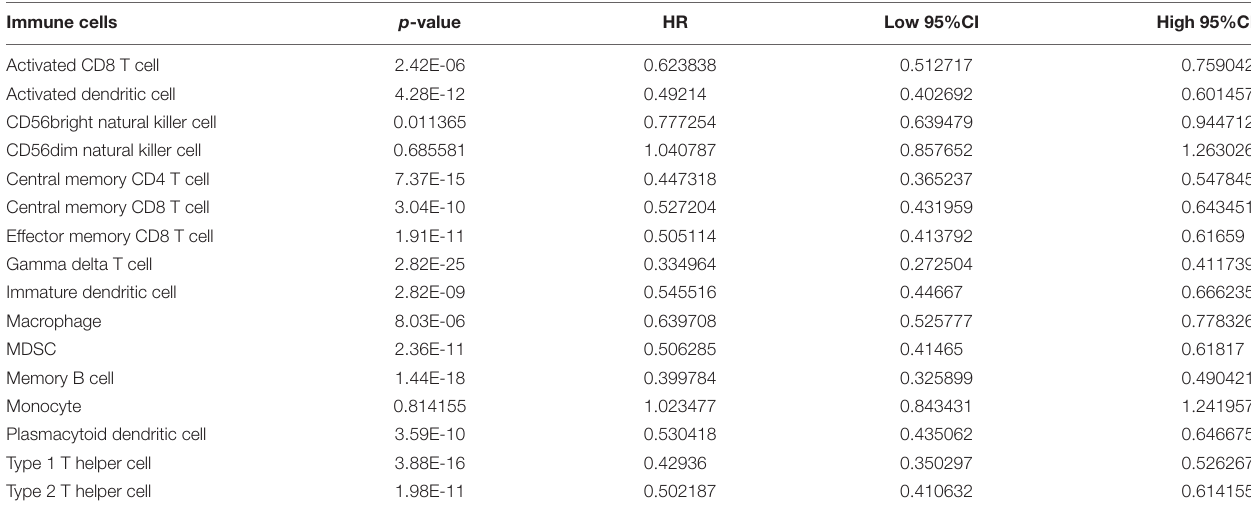
TABLE 2 | Proportion of immune cells in